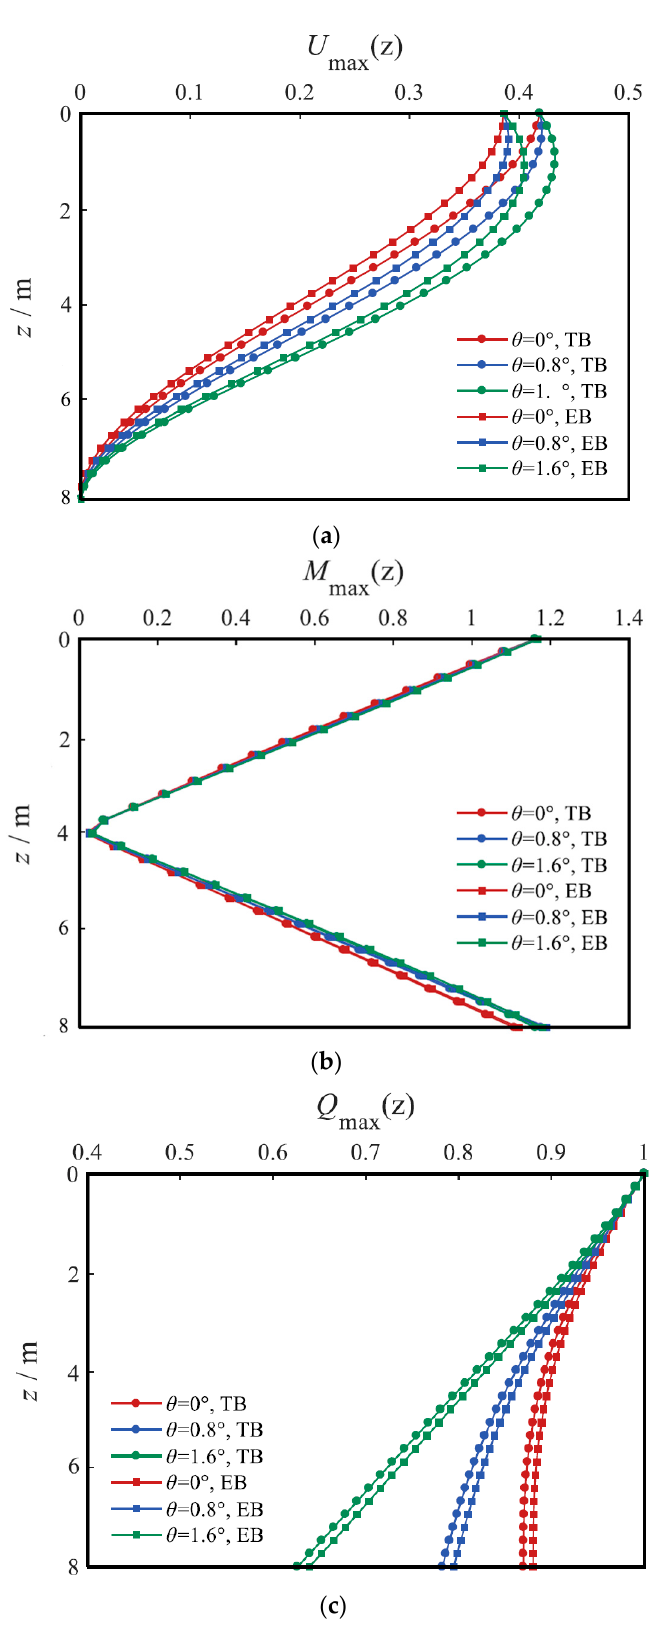
Figure 3. Comparison between the results obtained by TS beam model and EB beam model. ( a ) Horizontal displacement envelope, ( b ) bending moment envelope, ( c ) shear force envelope.